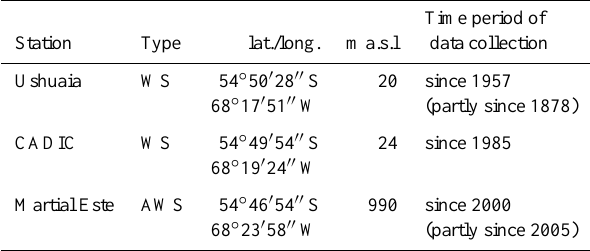
Table 1. Overview of the weather stations which provided the nec- essary air temperature and precipitation data records for this